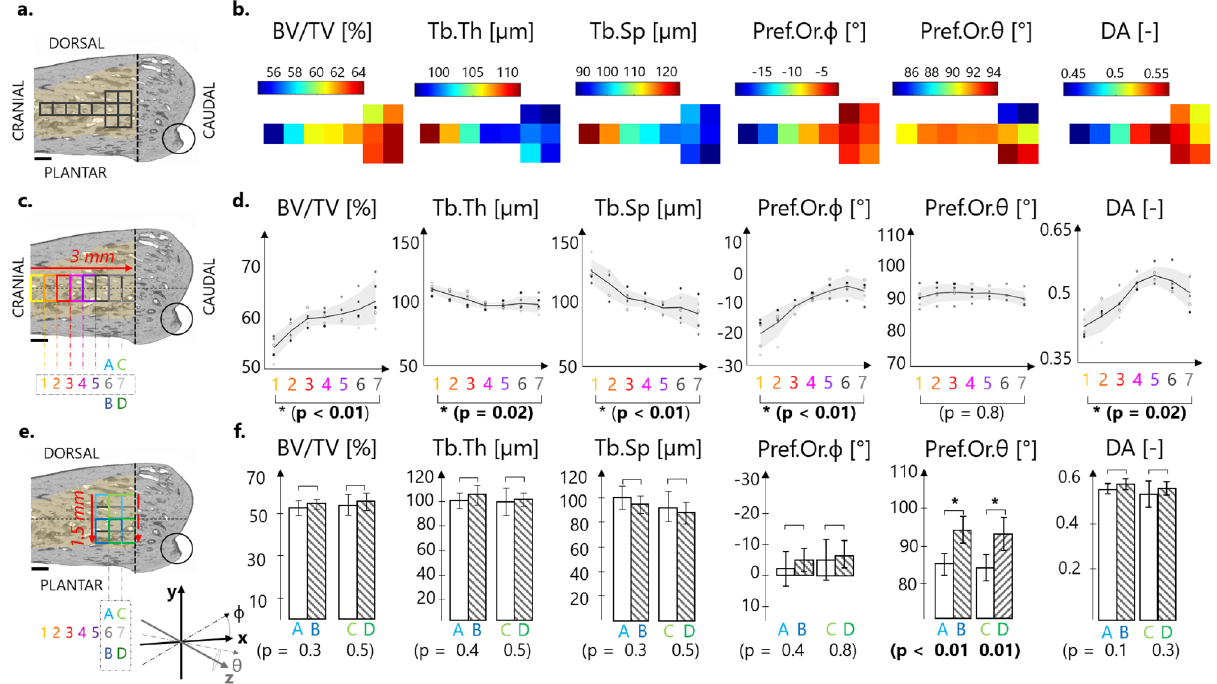
Figure 5. Three-dimensional spatially resolved analysis of trabecular bone architecture (the analyzed trabecular compartment is highlighted in yellow). ( a ) Overview of the central part of the regions of interest (black squares), with the analyzed parameters color-coded in (B). ( b ) Spatial evolution of bone microstructural parameters along the cranio-caudal (CC) and the dorso-plantar (DP) directions. ( c ) Illustration of the volumes of interest (VOI) for the CC investigation at 7 consecutive positions (i.e., 1, …, 7). ( d ) Spatial evolution of morphometric parameters along the CC direction showing significant variations in BV/TV, Tb.Sp and Pref.Or. comparing the two extremities (i.e., positions 1 and 7). ( e ) Illustration of the VOI for the DP investigation considering 2 dorsal (A and C) and 2 plantar (B and D) locations. ( f ) Comparison of trabecular parameters averaged within dorsal and plantar regions revealing significant changes only for Pref.Or.θ. Scale bars: 500 µm. Statistically significant p values (p < 0.05) are shown in